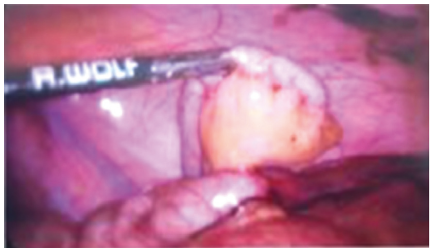
Figure 2: Appendix lifted with atraumatic laparoscopy forceps appears mildly congested.